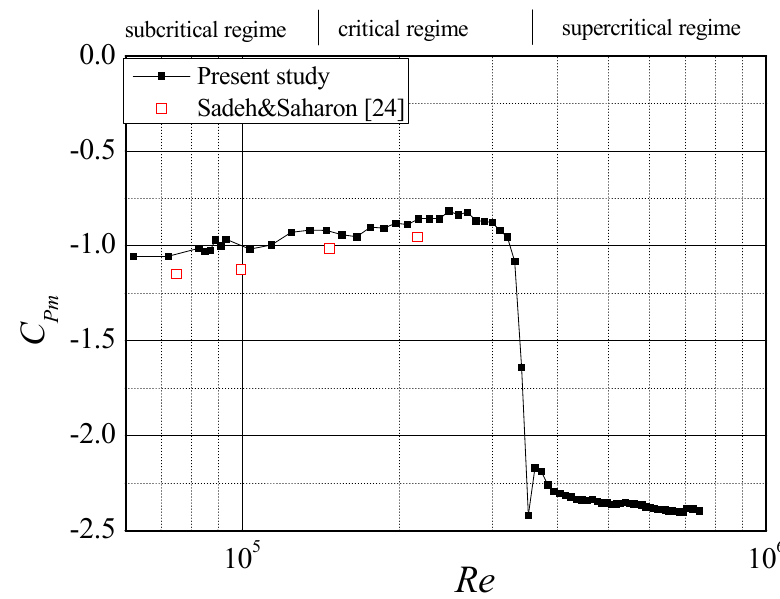
Figure 6. Minimum wind pressure coe ffi cient C pm in the smooth flow. Figure 6 . Minimum wind pressure coefficient C pm in the smooth flow. Figure 6 . Minimum wind pressure coefficient C pm in the smooth flow.